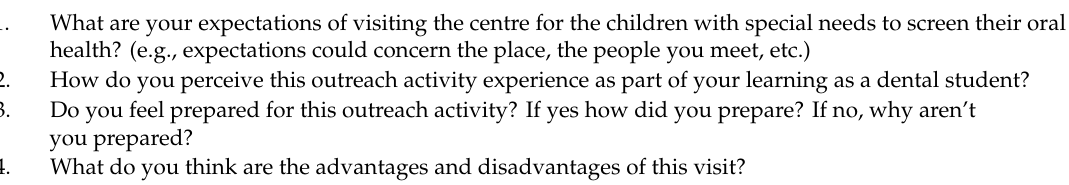
Table 1. The list of the open-ended questions before the fieldwork